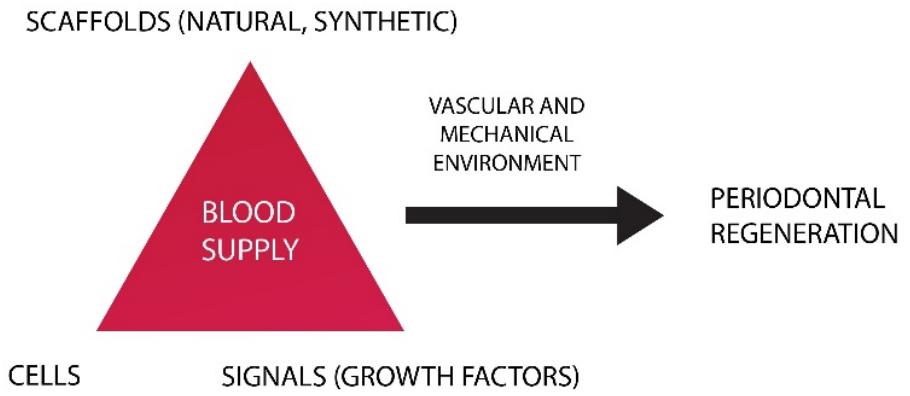
Figure 6. Tissue engineering triad.